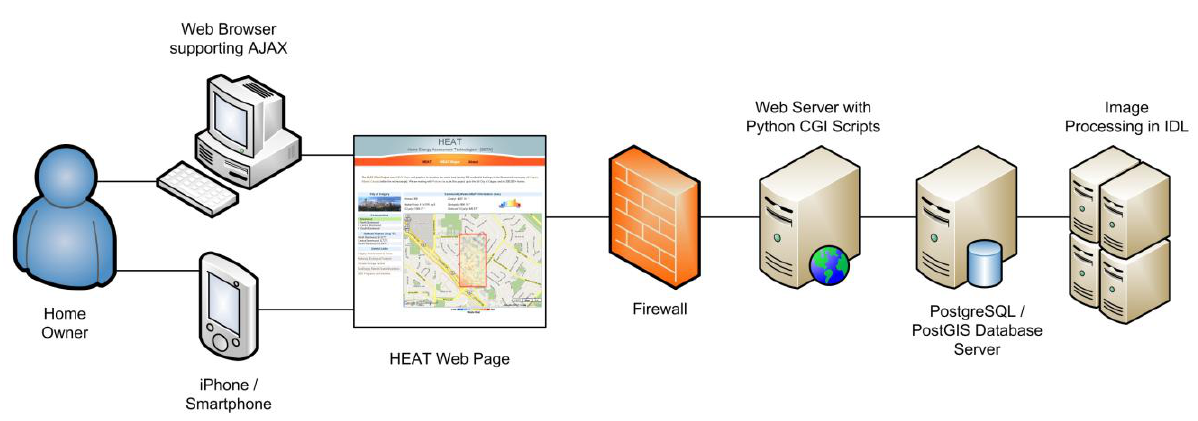
Figure 2. Overview of the HEAT processing